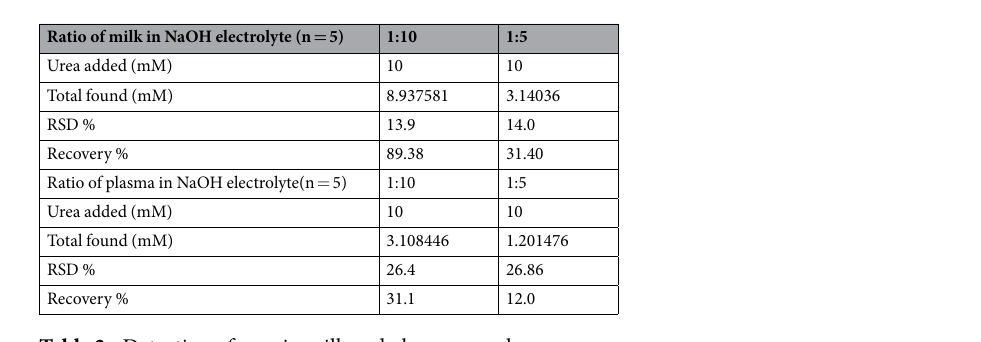
Table 2. Detection of urea in milk and plasma